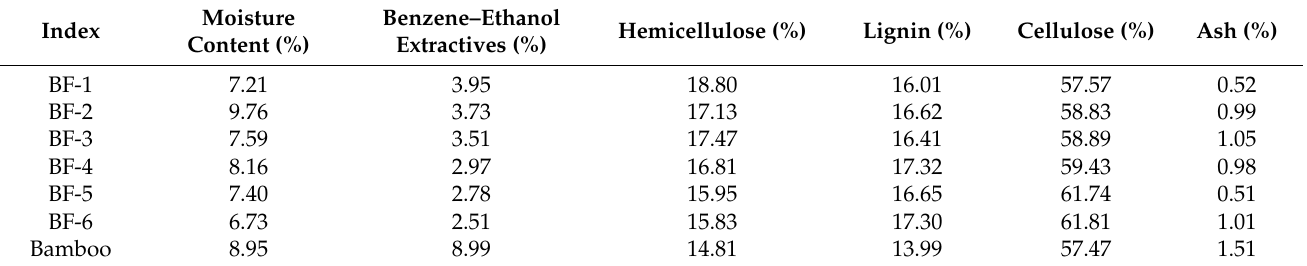
Table 1. Chemical composition of bamboo fibers with different opening